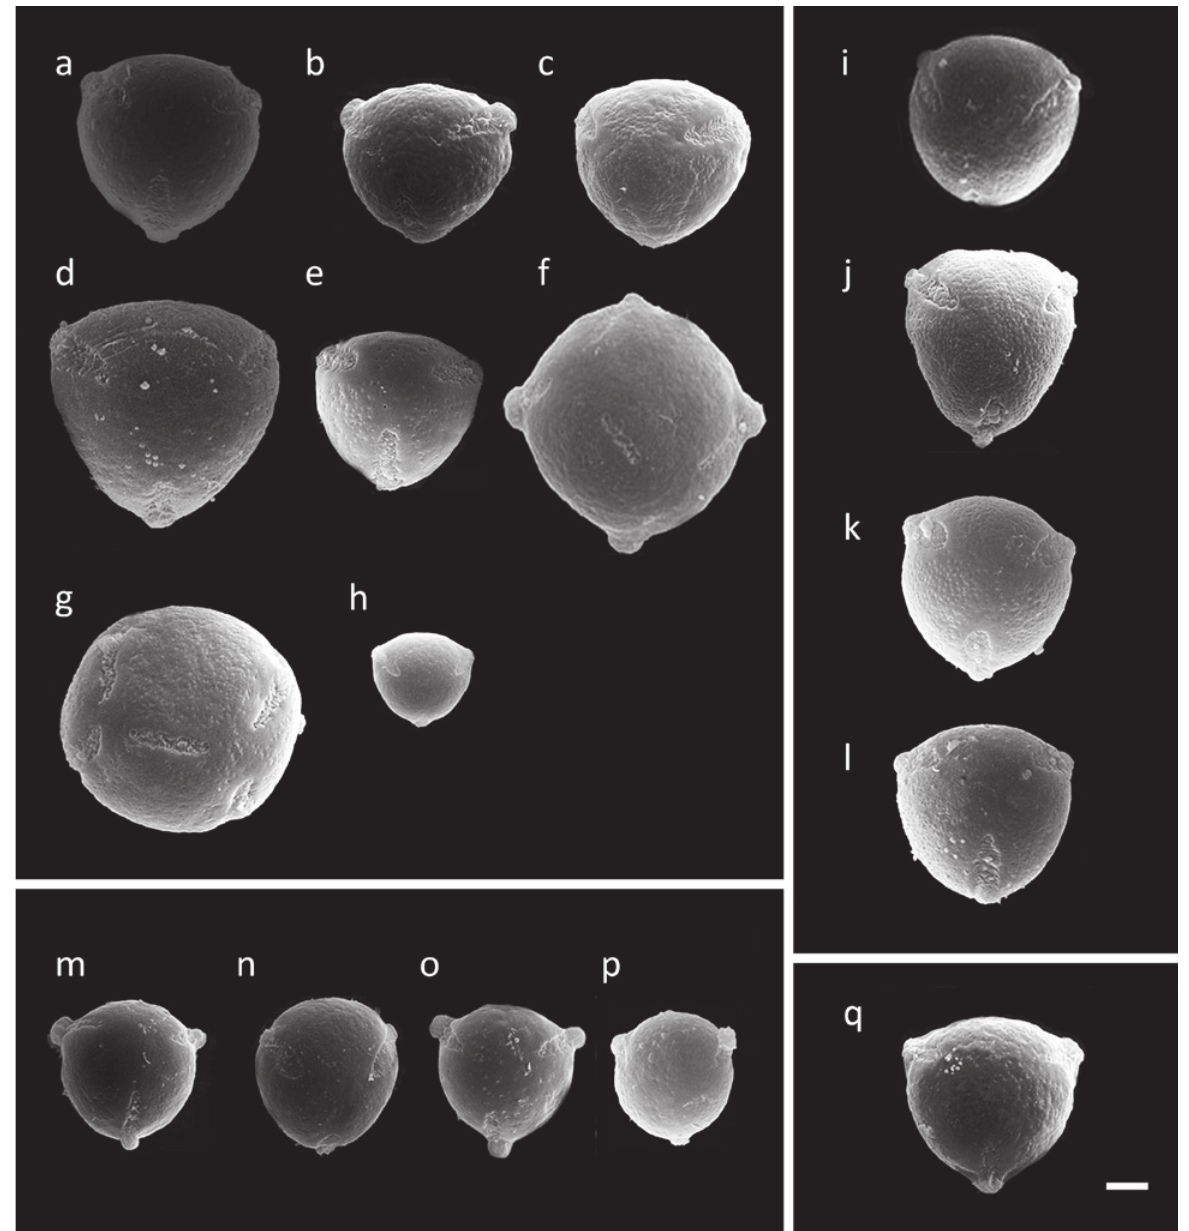
Fig. 1 - Pollen of 17 Lippia species in polar view. Zapania Schauer section : (a) L. alba , (b) L. aristata , (c) L. corymbosa , (d) L. diamantinensis , (e) L. hermanioides , (f) L. lacunosa , (g) L. rotundifolia , (h) L. rubella ; Rhodolippia Schauer section: (i) L. florida , (j) L. lupulina , (k) L. pseudothea , (l) L. rosella ; Goniostachyum Schauersection: (m) L. martiana , (n) L. pohliana , (o) L. salviifolia , (p) L. sidoides ; Dioicolippia Troncoso section : (q) L. filifolia . Bar = 8